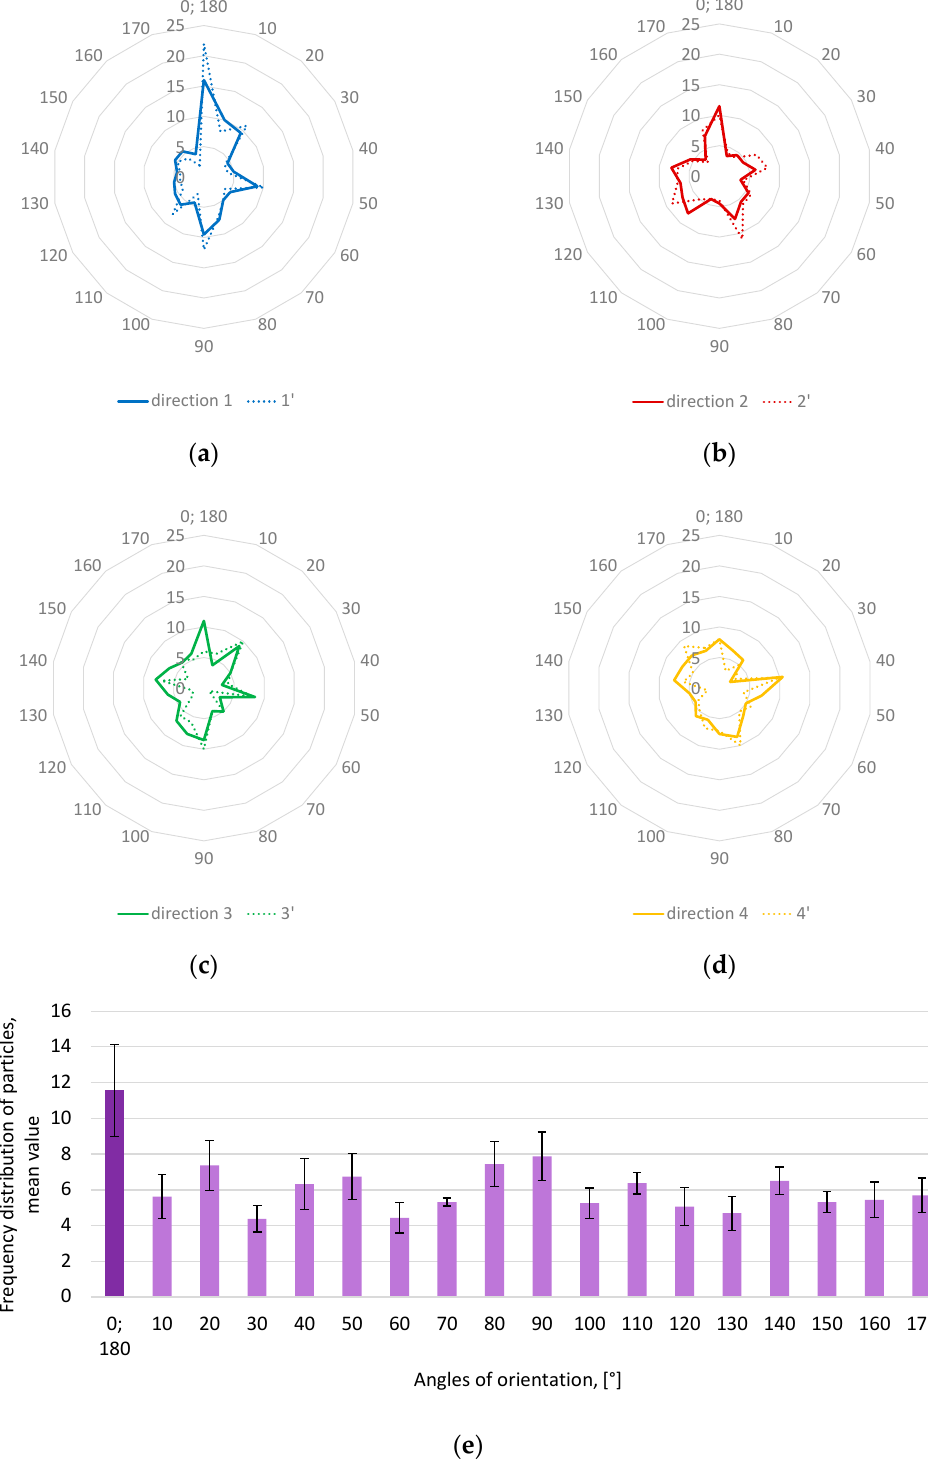
Figure 4. Frequency distribution of orientated grains with different orientations: ( a ) direction 1/1’; ( b ) direction 2/2’; ( c ) direction 3/3’; ( d ) direction 4/4’; and ( e ) mean value.